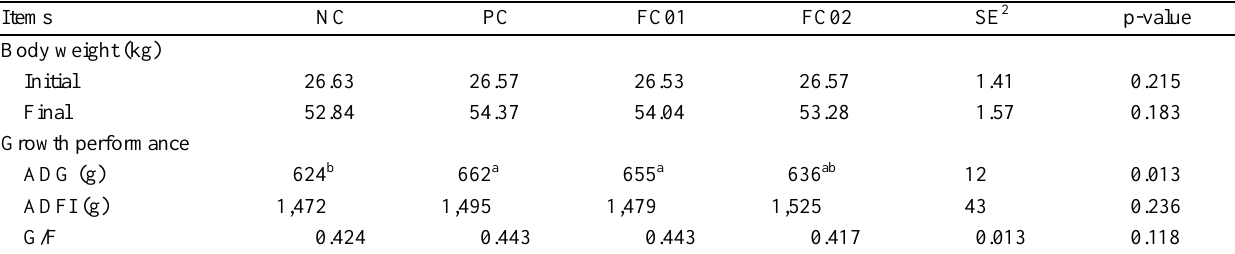
Table 2. Effect of fermented chlorella supplementation on growth performance in growing pigs 1